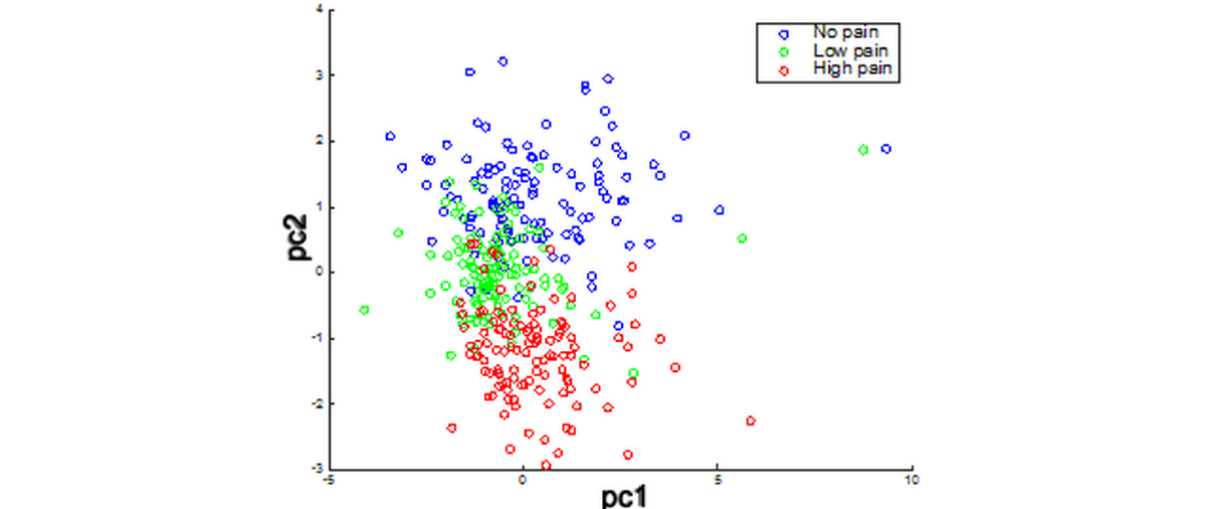
Figure 3. Principal component (pc) analysis of different pain levels showing all